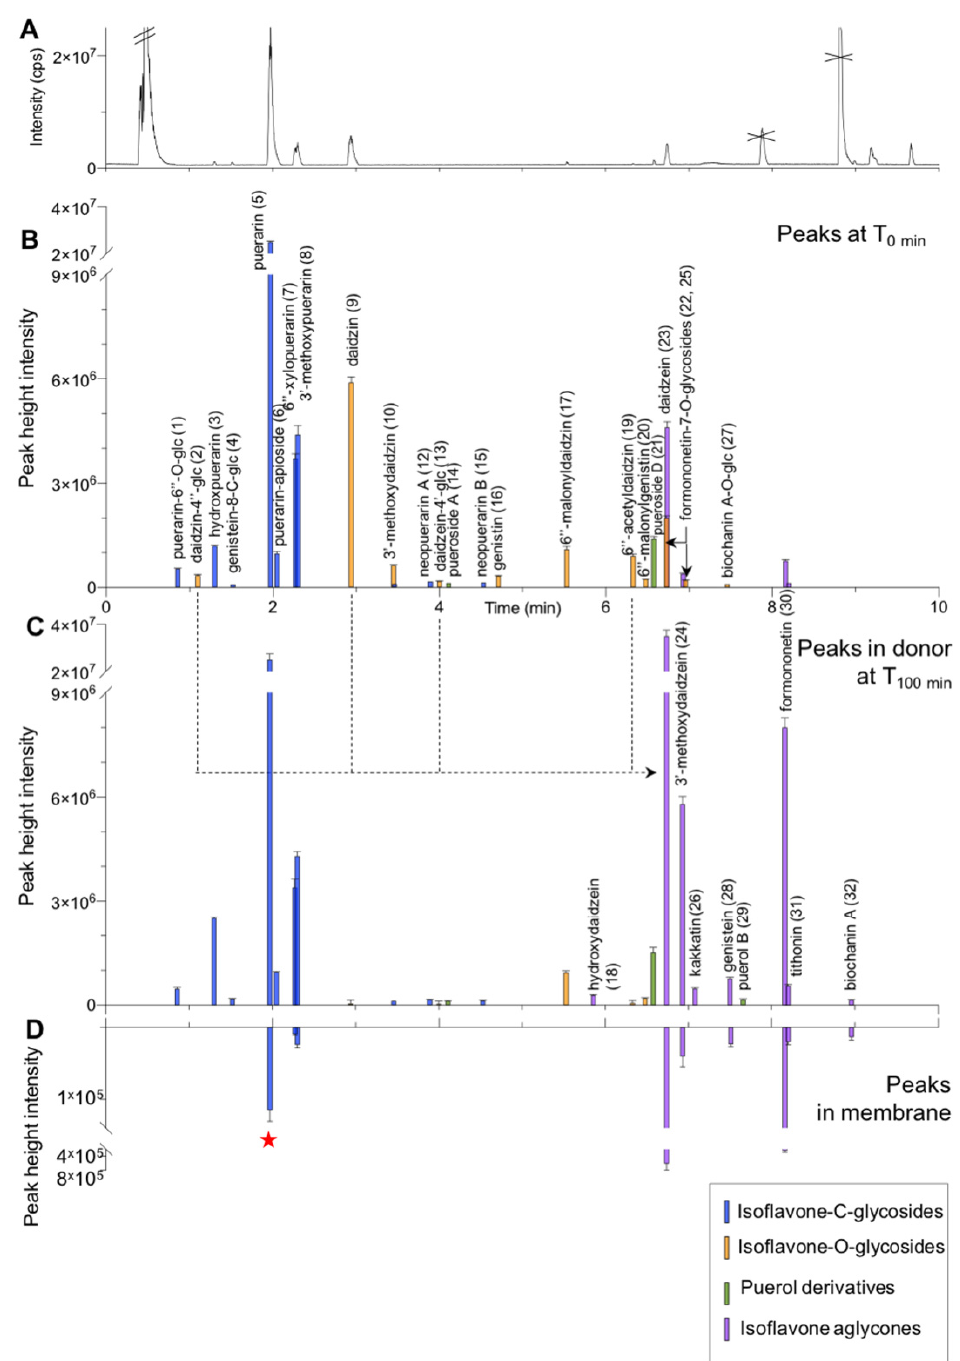
Figure 2. Monitoring of PLRE composition by metabolite profiling and peak picking during permeation experiments: ( A ) UHPLC-HRMS chromatogram of PLRE stock solution at 200 µg/mL. ( B – D ) Bar chromatograms of the annotated peaks, ( B ) in the stock solution ( C ) in the donor compartments at 100 min, and ( D ) peaks detected in the membrane. Peak heights are represented as mean ± SD, stock solution: n = 3 (analytical replicates), donor compartments and membrane n = 4 (experimental replicates). See Tables 1–4 for the annotations. The red star on ( 5 ) indicates that this peak was also detected in the acceptor compartment.